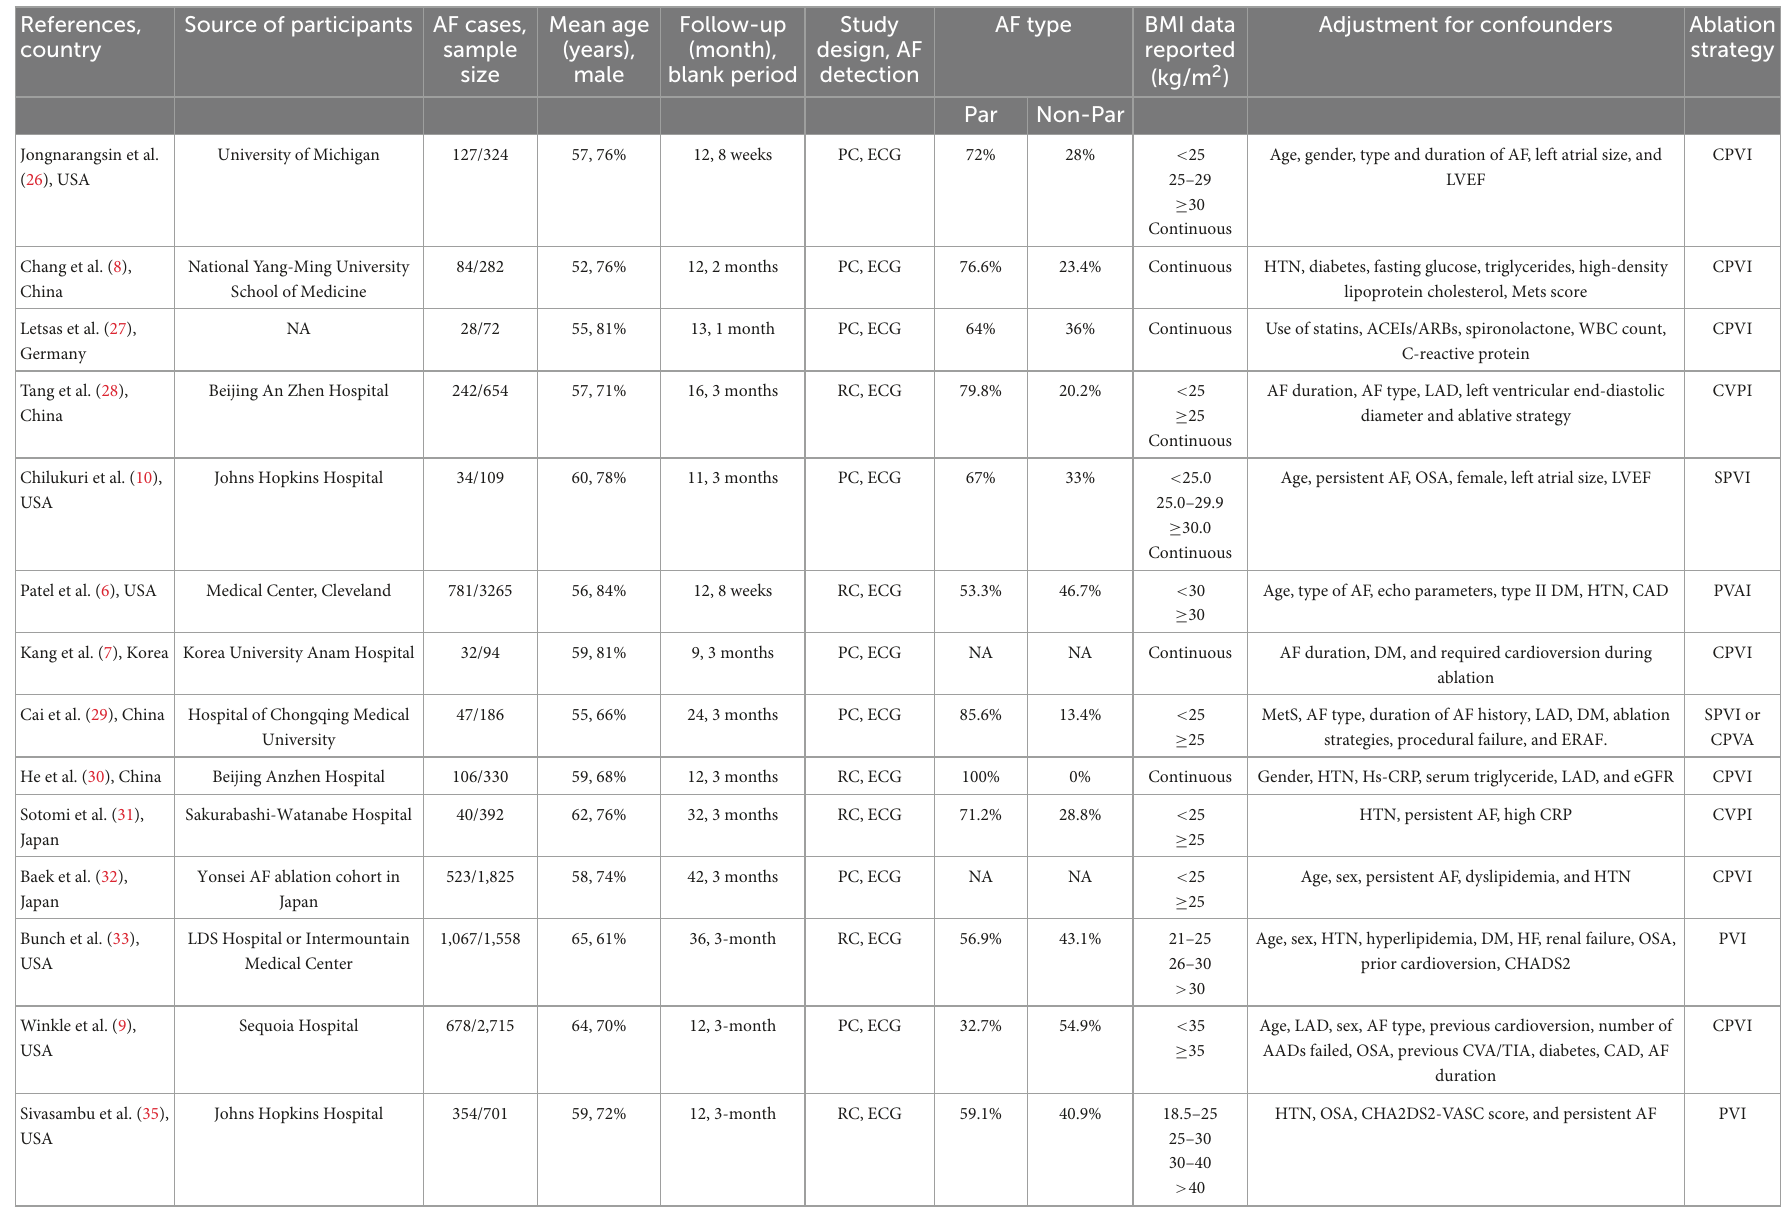
TABLE 1 Basic characteristics of the included studies in the dose-response meta-analysis of BMI and AF recurrence in patients post ablation. References,